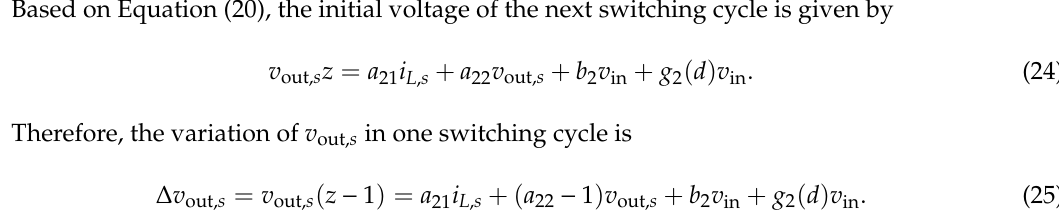
Figure 10. Output voltage under a steady state, where d [ k + 1] = 1 and d [ k + 1] = 0.